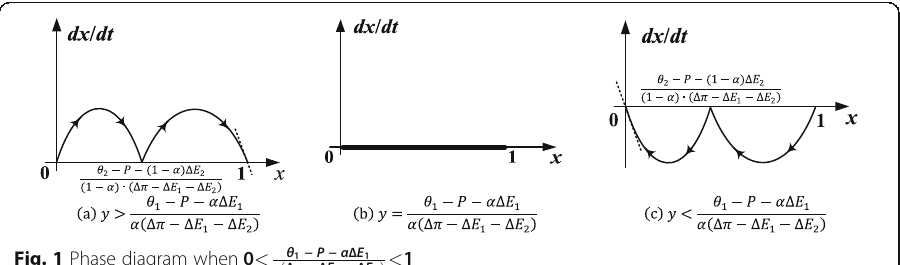
Fig. 1 Phase diagram when 0 < θ 1 − P − α Δ E 1 α